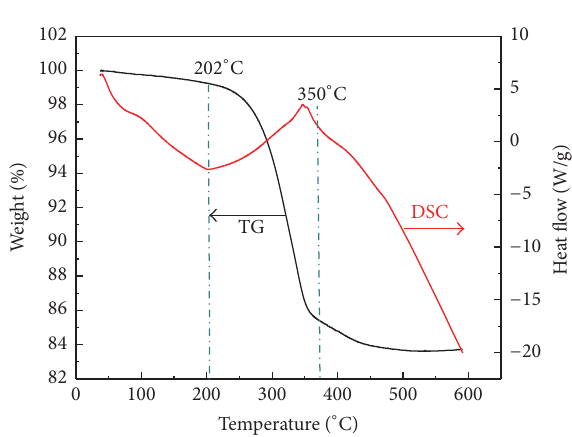
Figure 1: TGA-DSC curves of V 2 O 5 catalyst